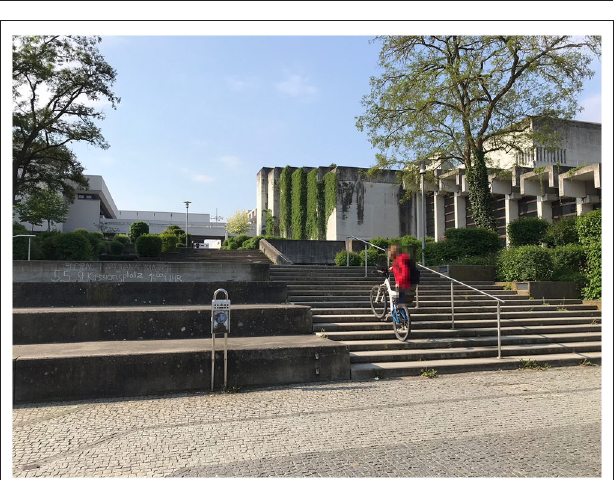
FIGURE 2 | It is not clear how to circumnavigate these stairs. As there are no bike ascents, the bike has to be carried all the way up, which makes it difficult and uncomfortable to use the bike on campus (Photo: U2